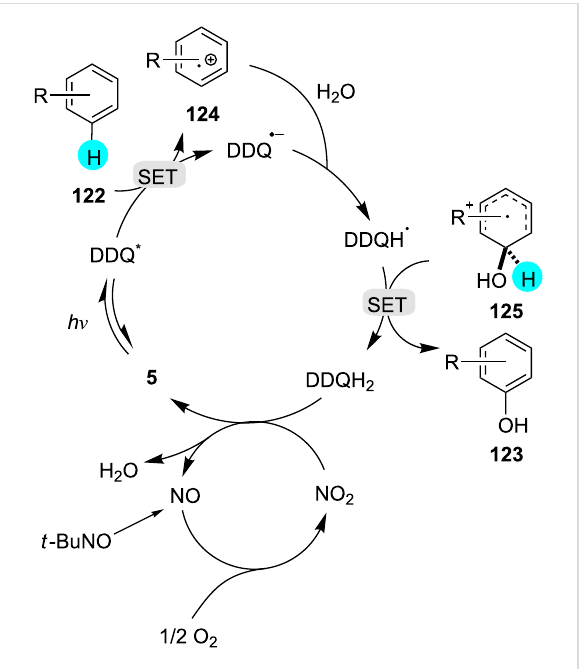
Figure 20: Possible mechanism for the generation of phenols with the aid of photoredox catalyst 5